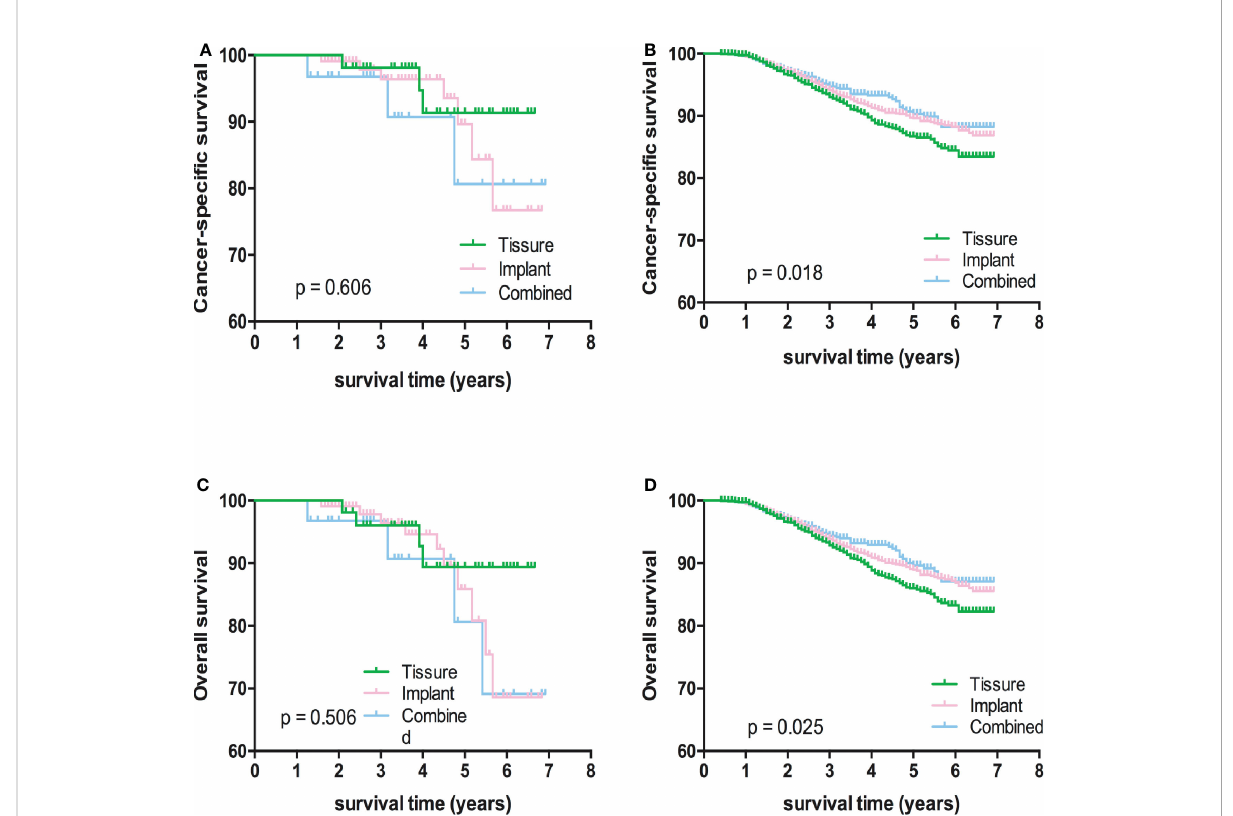
FIGURE 4 Kaplan-Meier analyses of CSS (A, B) and OS (C, D) among patients with or without radiotherapy strati fi ed according to reconstructive